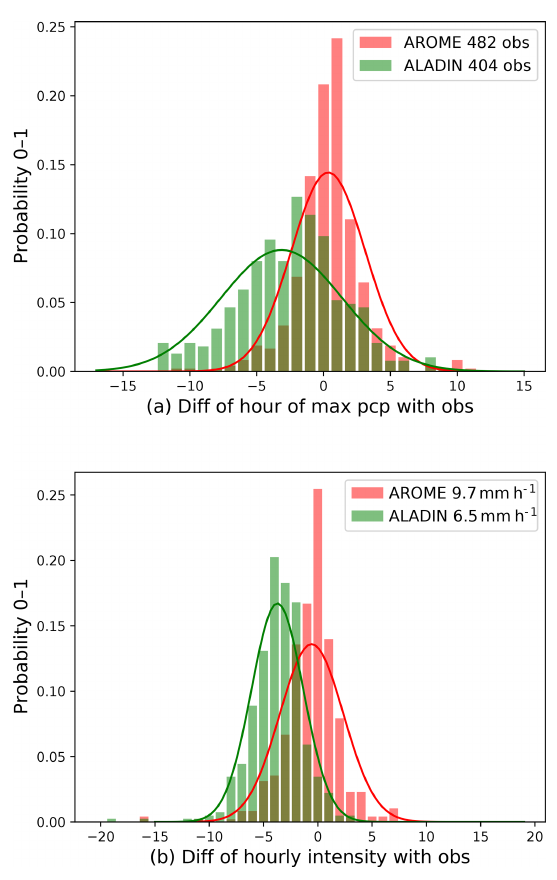
Figure 7. Histograms of differences between models (HCLIM- AROME 2.5km and HCLIM-ALADIN 12km) and observations of the 10-year mean of (a) the hour of maximum precipitation and (b) the corresponding maximum hourly intensity for the hourly in- tensity threshold of 5mmh − 1 . The legend shows (a) the number of stations used in the comparison for each of the models and (b) the mean intensity for each model. The mean intensity in observations is 10.2mmh − 1